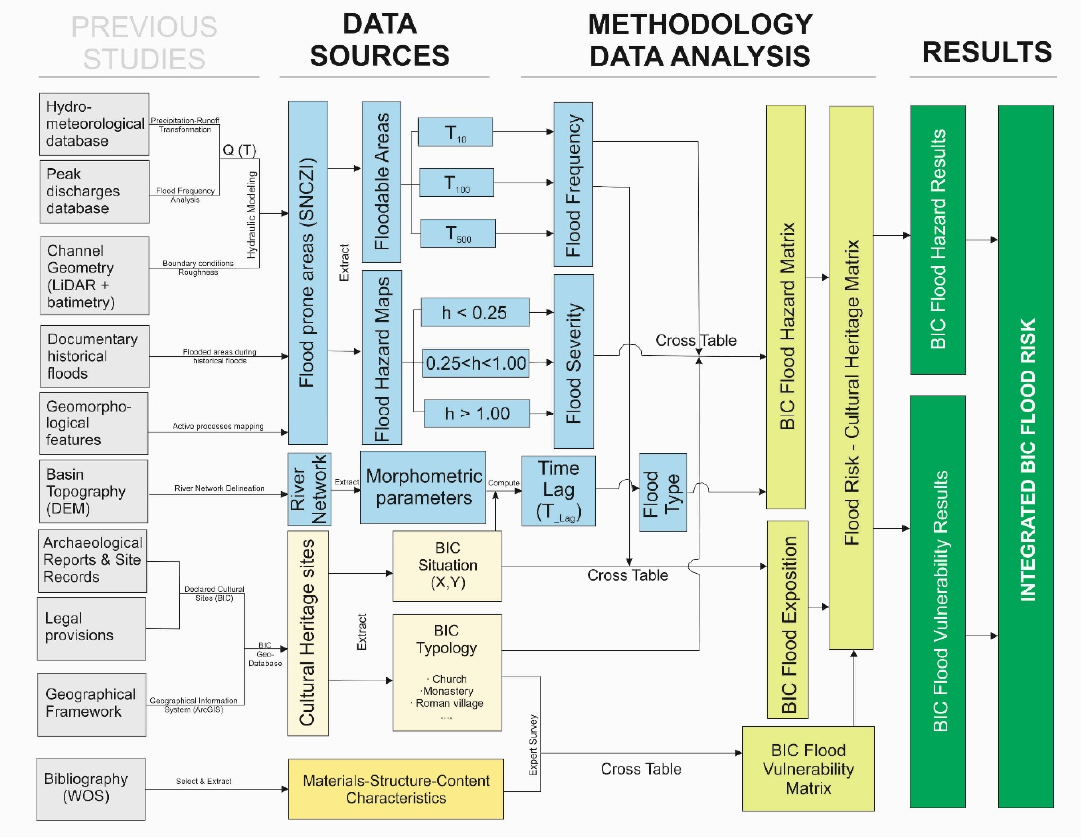
Figure 2. Methodological flow chart developed for the estimation of potential flood risk in the cultural heritage elements or sites. “T” is return period (in years), and “h” is water depth (in meters).